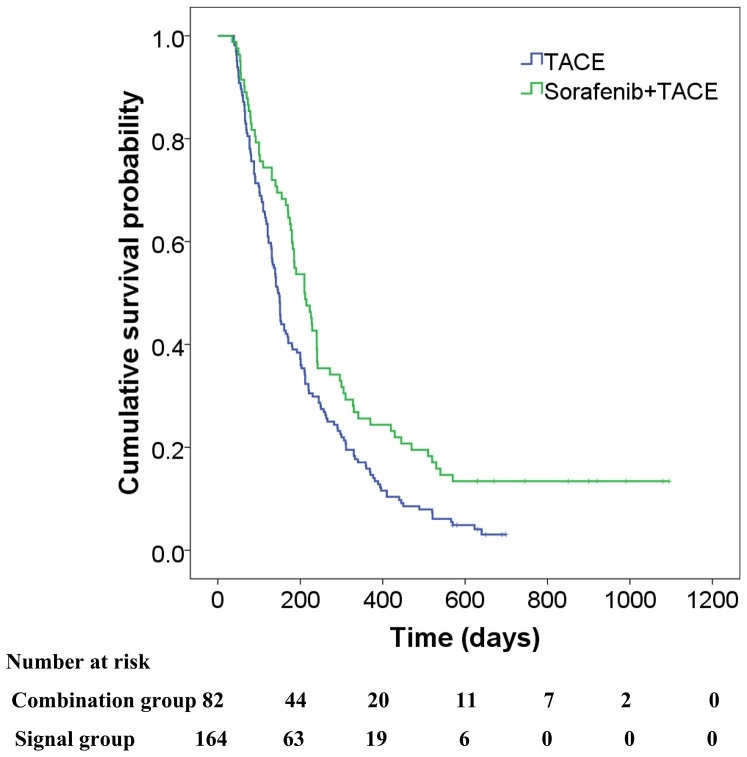
Kaplan–Meier analysis of OS of the combined and monotherapy groups.The Kaplan–Meier curves show the OS of the combined and monotherapy groups for propensity-matched patients. The median OS of the combined group was significantly longer compared with the monotherapy group in the matched model (7.0 months vs 4.9 months, respectively; P =  0.003).